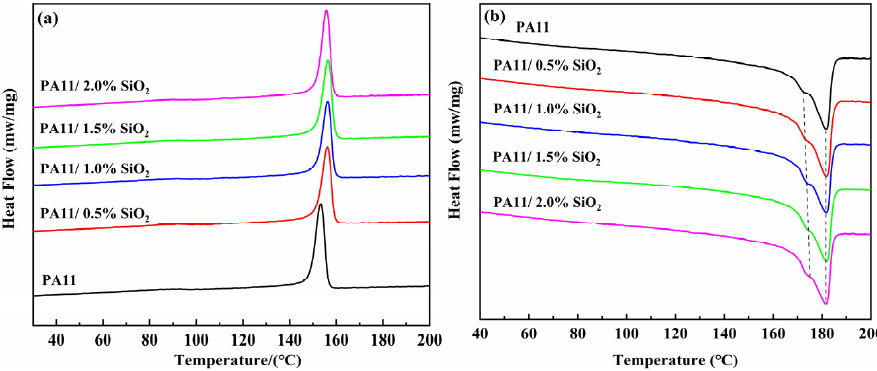
Figure 5. DSC curves of PA11/SiO 2 composites: ( a ) crystallization curve, ( b ) melting curve. Table 1. DSC thermodynamic parameters of PA11/SiO 2 composites.